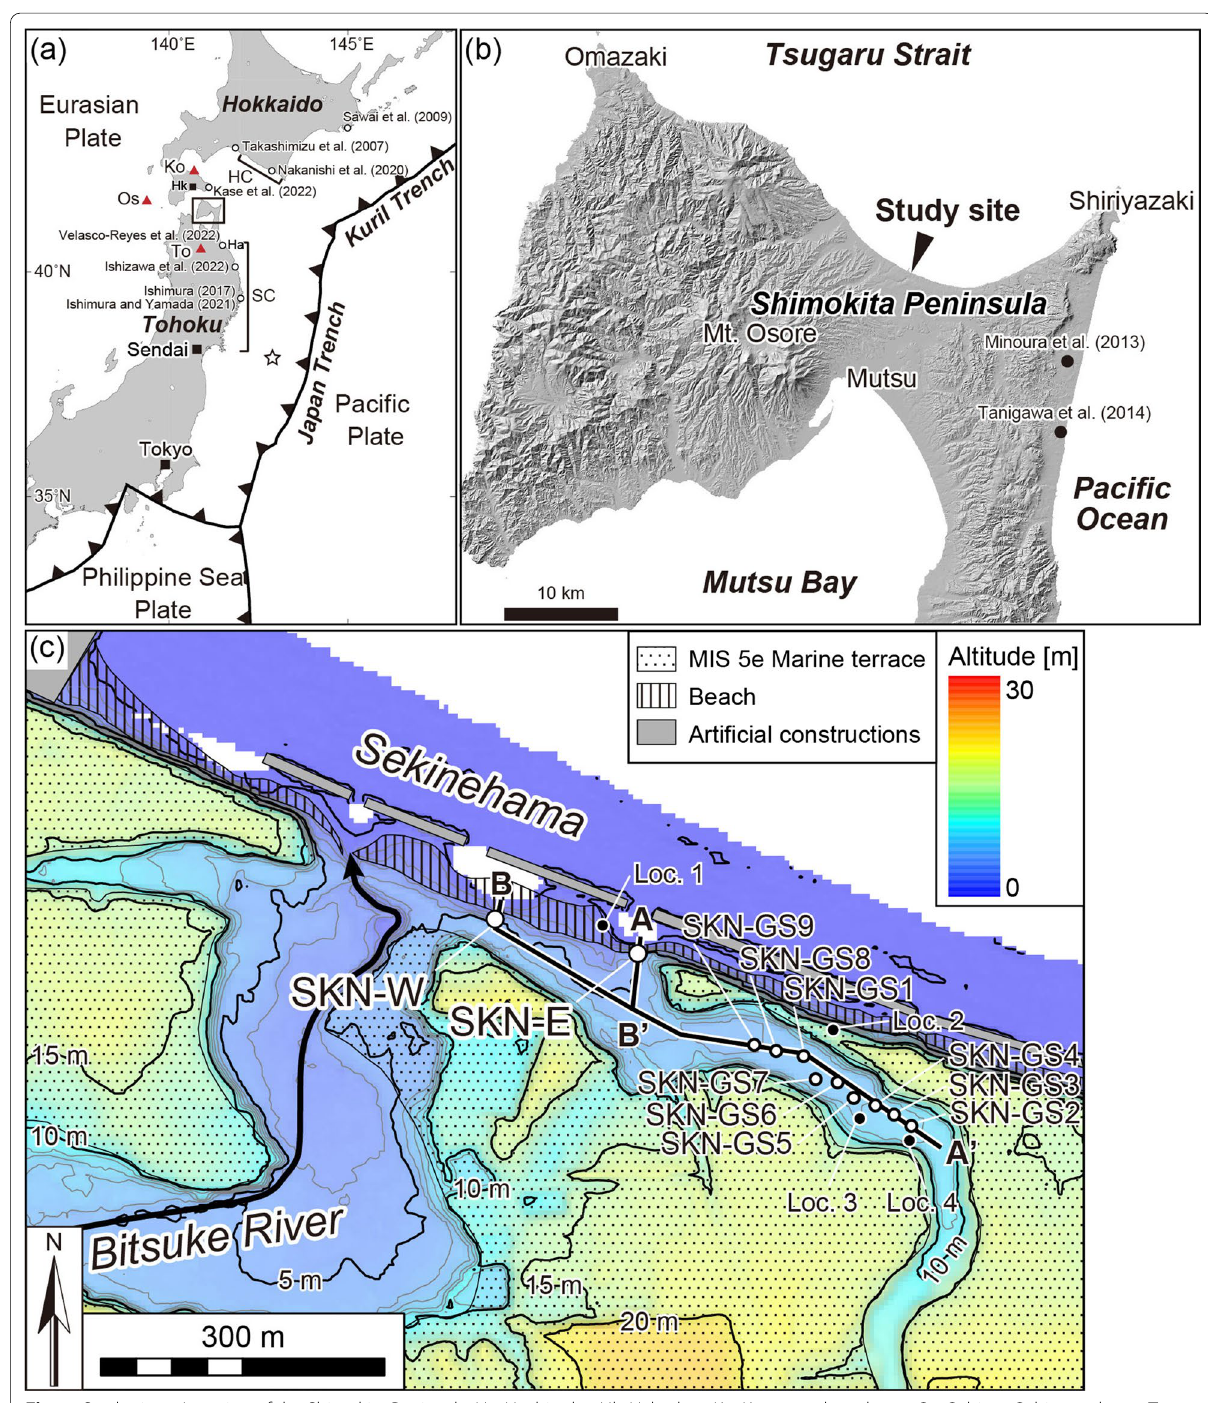
Fig. 1 Study site. a Location of the Shimokita Peninsula. Ha: Hachinohe. Hk: Hakodate. Ko: Komagatake volcano. Os: Oshima-Oshima volcano. To: Towada volcano. SC: Sanriku Coast. HC: Hidaka Coast. Star denotes the epicenter of the 2011 Tohoku-oki earthquake. Rectangle indicates area represented by ( b ). b Northern Shimokita Peninsula. Shaded relief map is based on a 10-m-mesh digital elevation model (DEM) from the Geospatial Information Authority of Japan (GSI). c Map of the Sekinehama Coast and vicinity. Contours are based on the 5-m-mesh DEM from GSI. Intervals of gray and black contours are 1 m and 5 m, respectively. Curving arrow denotes the channel and flow direction of the Bitsuke